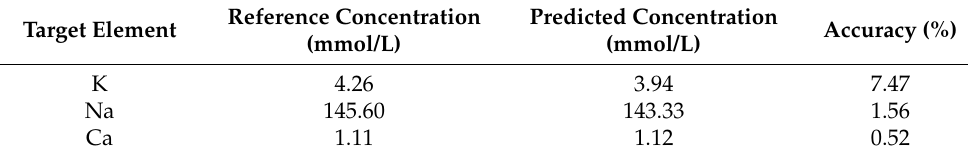
Figure 6. The quantitative analysis of elements in blood serum on filter paper. ( a ) K; ( b ) Na; ( c ) Ca. Table 2. The results for blood serum on filter paper using the test